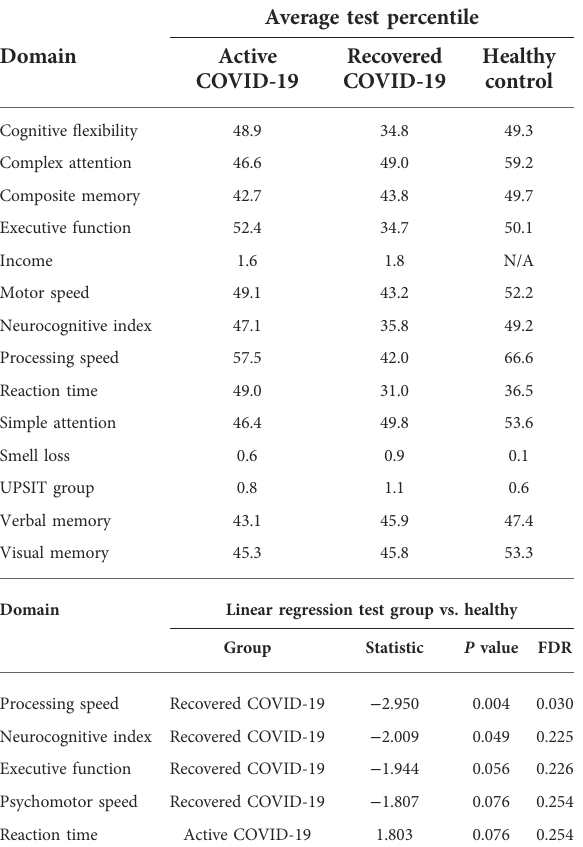
TABLE 5 Subsets of cognitive testing versus COVID diagnosis